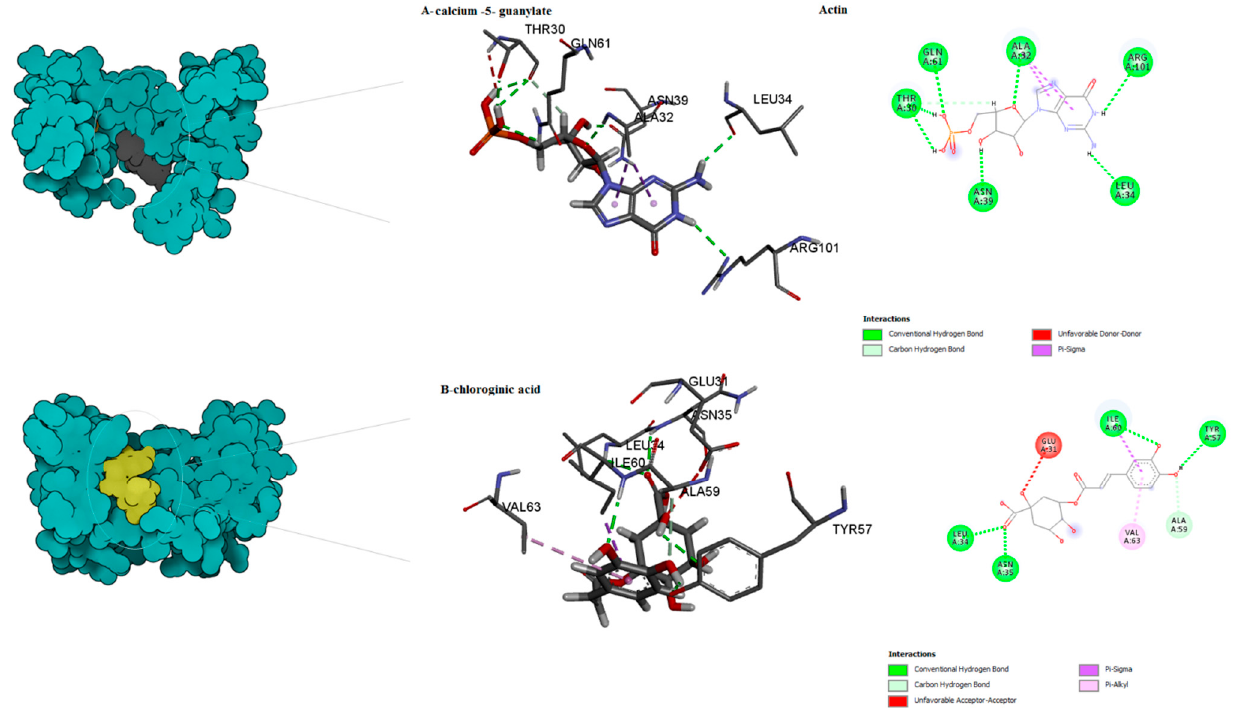
Figure 4. Predicted binding mode for actin with calcium 5- guanylate and chlorogenic acid.